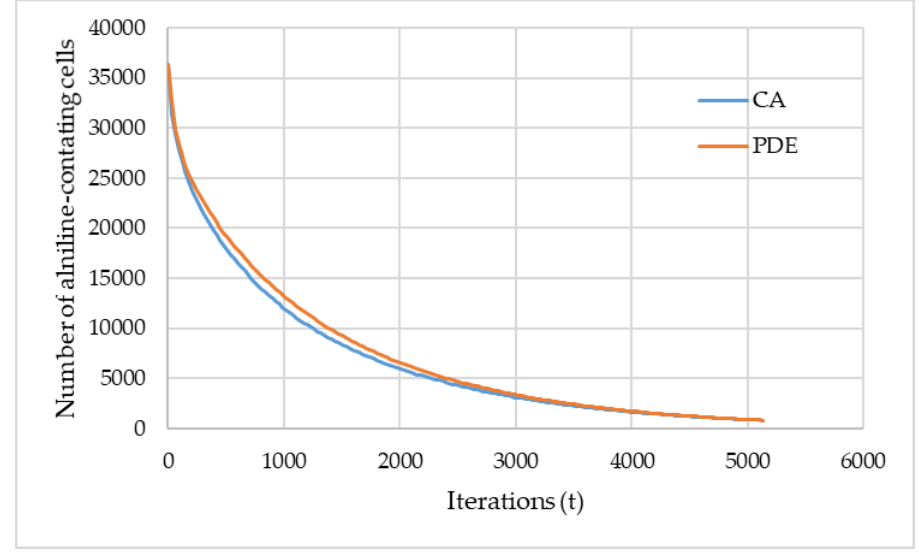
Figure 8. Cellular automata model in comparison with PDE numerical solution.